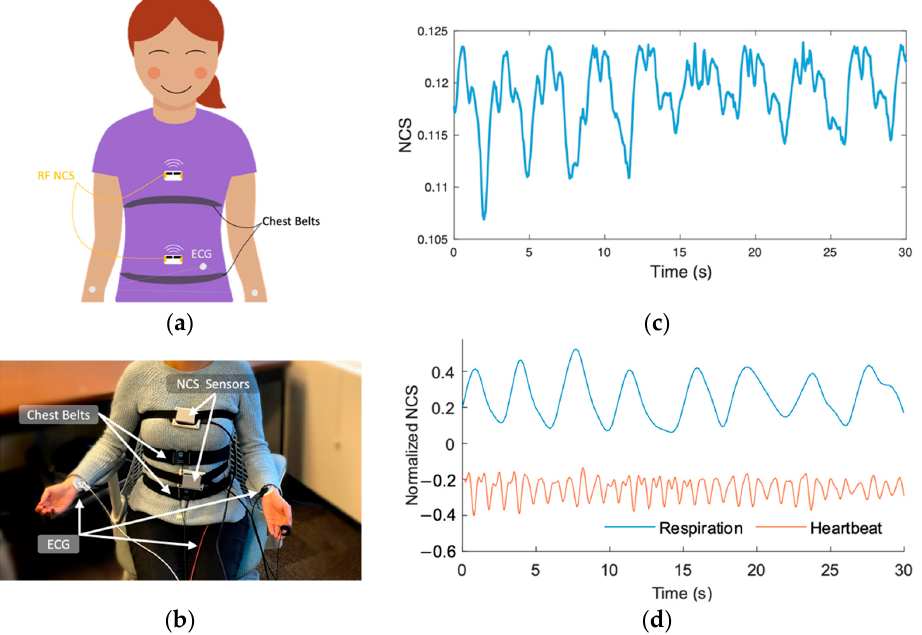
Figure 1. ( a ) Setup showing NCS RF sensors near the heart and diaphragm, and reference thorax and abdomen chest belts and ECG. ( b ) A subject wearing the setup, with wired NCS sensors. Newer version enables Bluetooth data transfer. ( c ) A 30 s segment showing raw respiration and heartbeat modulation on NCS signal. ( d ) Filtered and normalized heartbeat and respiration extracted from the NCS thorax and abdomen sensors,